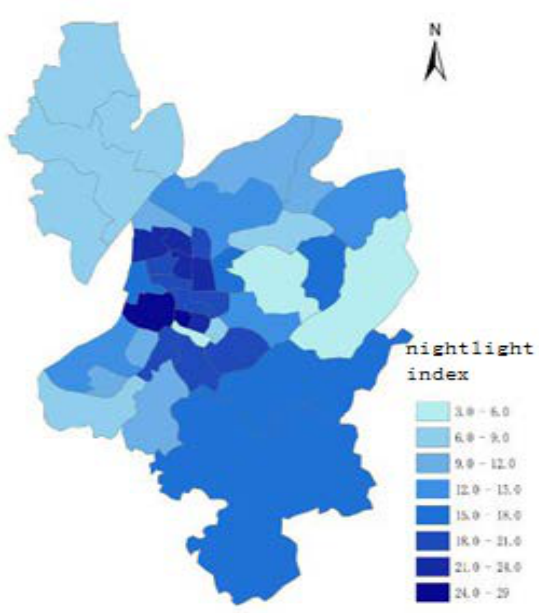
Figure 3 map of nightlight index for each